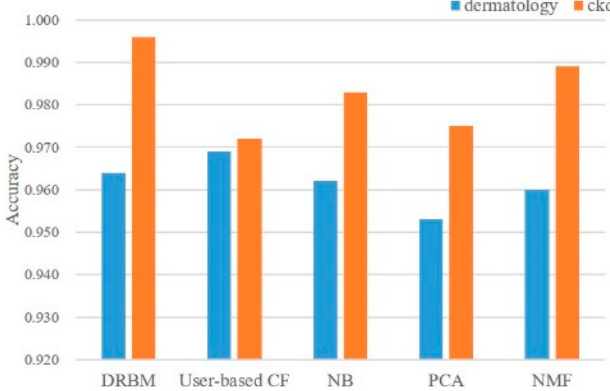
Figure 9. Comparative analysis of different classification methods with DRBM and user-based CF in terms of accuracy on baseline data.